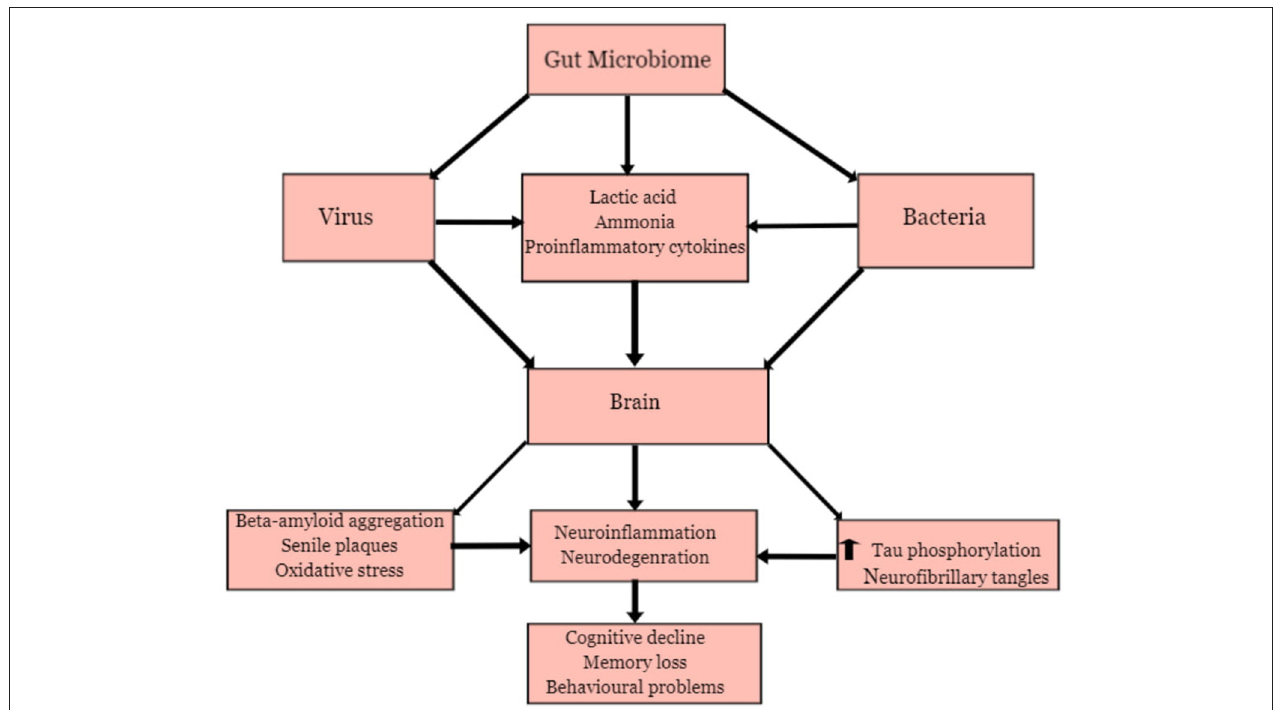
FIGURE 5 | Microbial Pathogenesis and Pathophysiology of Alzheimer’s